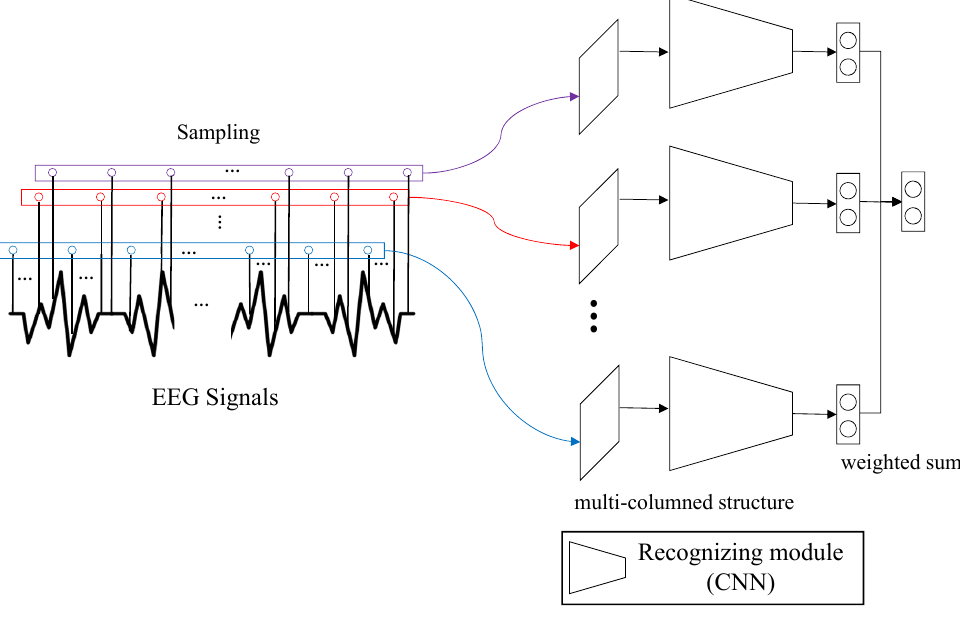
Figure 1. The overview of the algorithm. The EEG signals are sampled at k times and each sampled signal is an input to an individual recognizing module. The decisions of the modules are collected to make a final